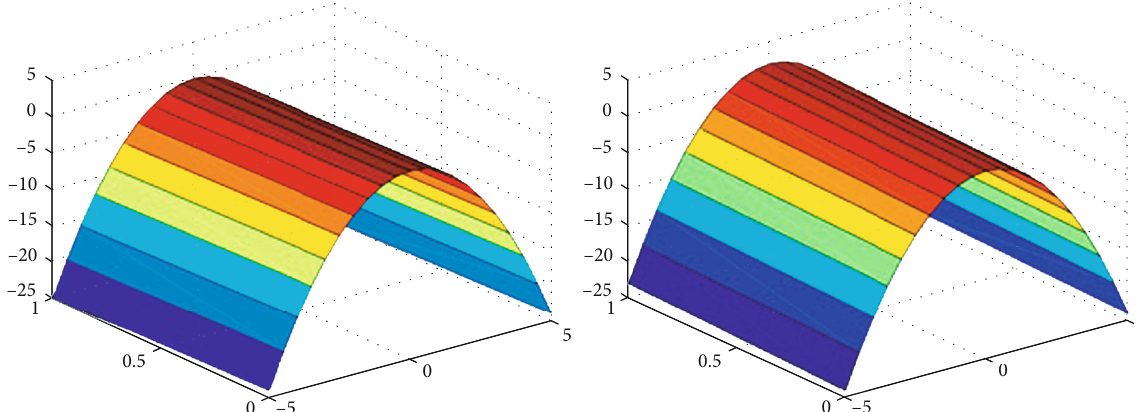
Figure 2: The fractional order of α = 0 : 8 and 0 : 6 of Problem